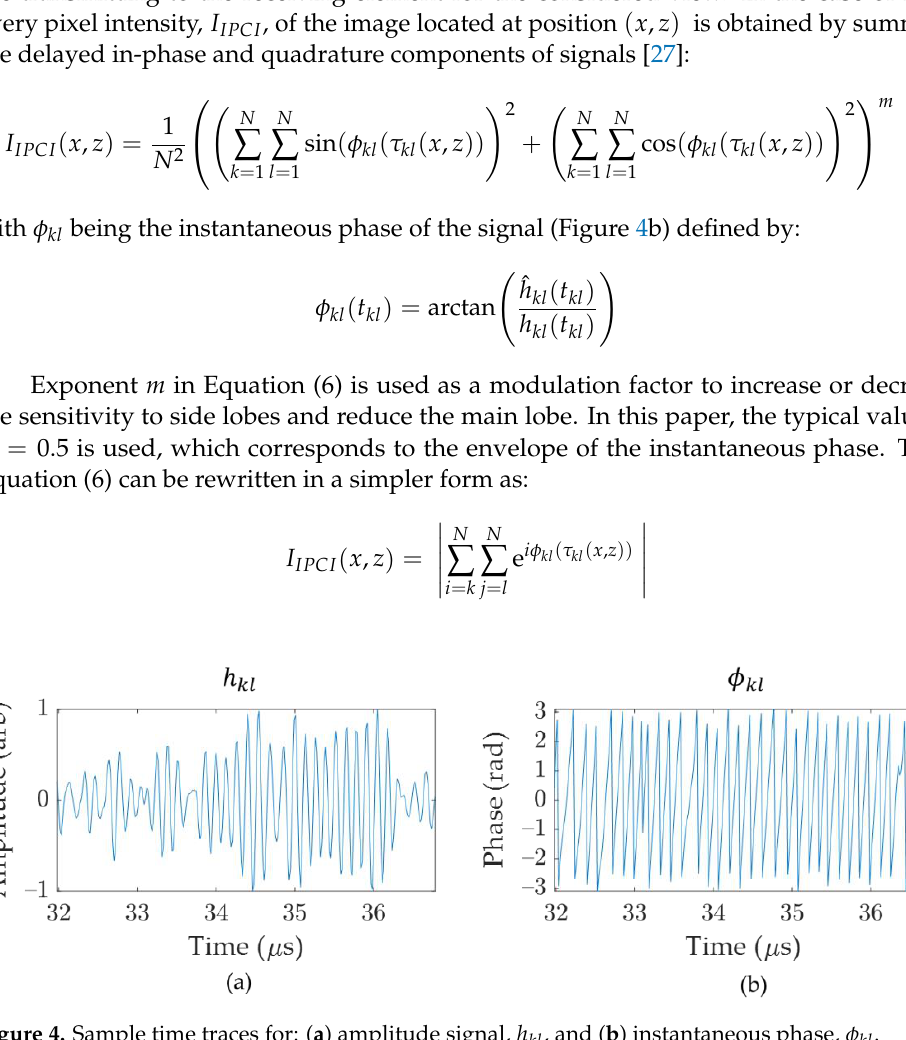
Figure 4. Sample time traces for: ( a ) amplitude signal, ℎ 𝑘𝑙 , and ( b ) instantaneous phase, 𝜙 𝑘𝑙 .